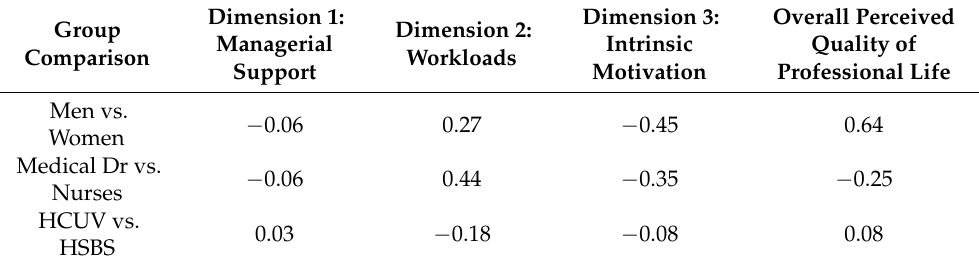
Table 5. Effect size between groups according Cohen’s d analysis.